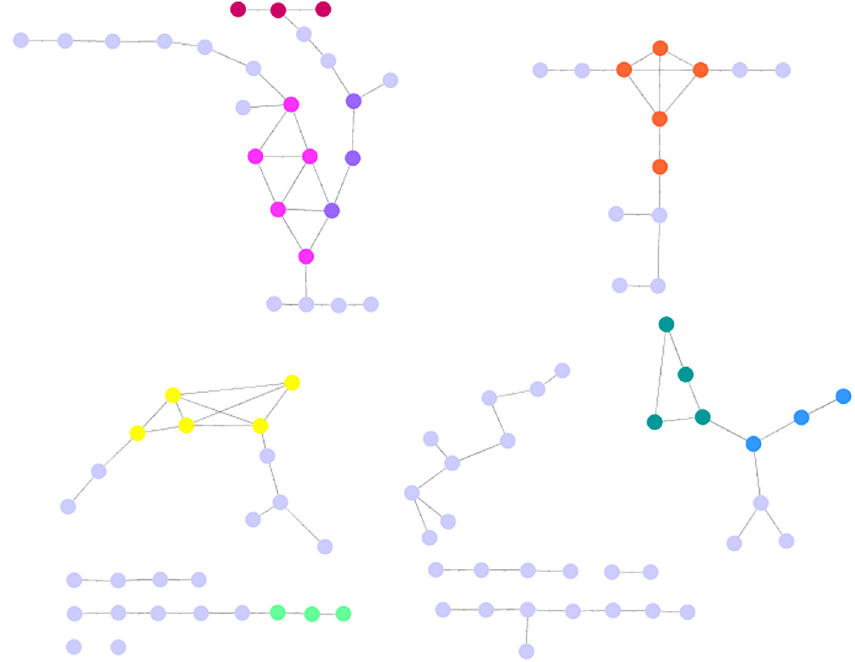
Fig 8. The CHIDS Causal Network After Node Removal by BC Rank. The CHIDS network after the sequential removal of 15 nodes by BC rank.